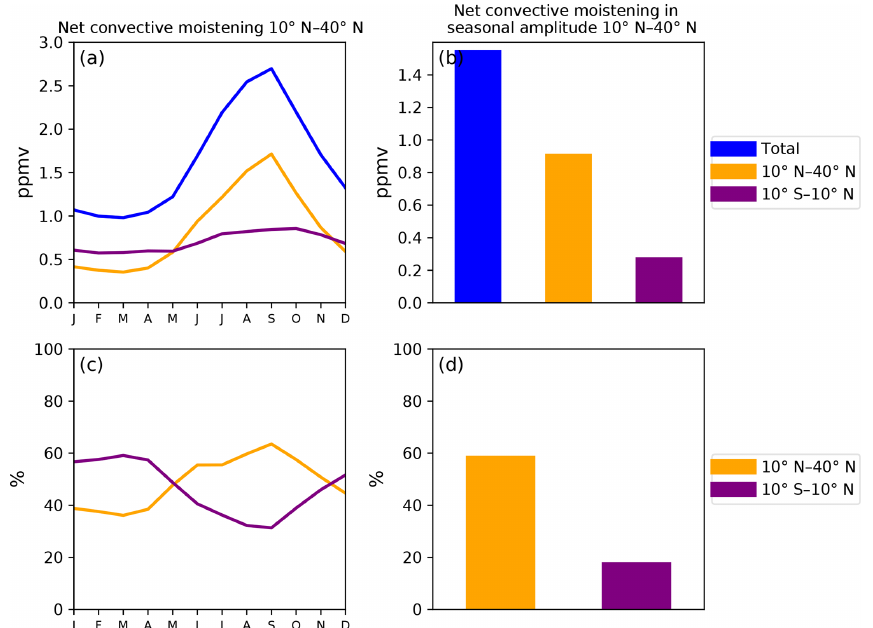
Figure 8. (a) Net convective moistening (ppmv) in the 100hPa 10–40 ◦ N water vapor seasonal cycle and the portions (ppmv) contributed by convective ice evaporation over 10 ◦ S–10 ◦ N and 10–40 ◦ N. (b) Net convective moistening (ppmv) in the 100hPa 10–40 ◦ N water vapor seasonal amplitude and the portions (ppmv) contributed by convective ice evaporation over 10 ◦ S–10 ◦ N and 10–40 ◦ N. (c–d) Percentage of net convective moistening in the 100hPa 10–40 ◦ N water vapor seasonal cycle and seasonal amplitude contributed by convective ice evaporation over 10 ◦ S–10 ◦ N and 10–40 ◦ N. The percentage is net convective moistening contributed by the 10 ◦ S–10 ◦ N or 10–40 ◦ N region divided by the total net convective